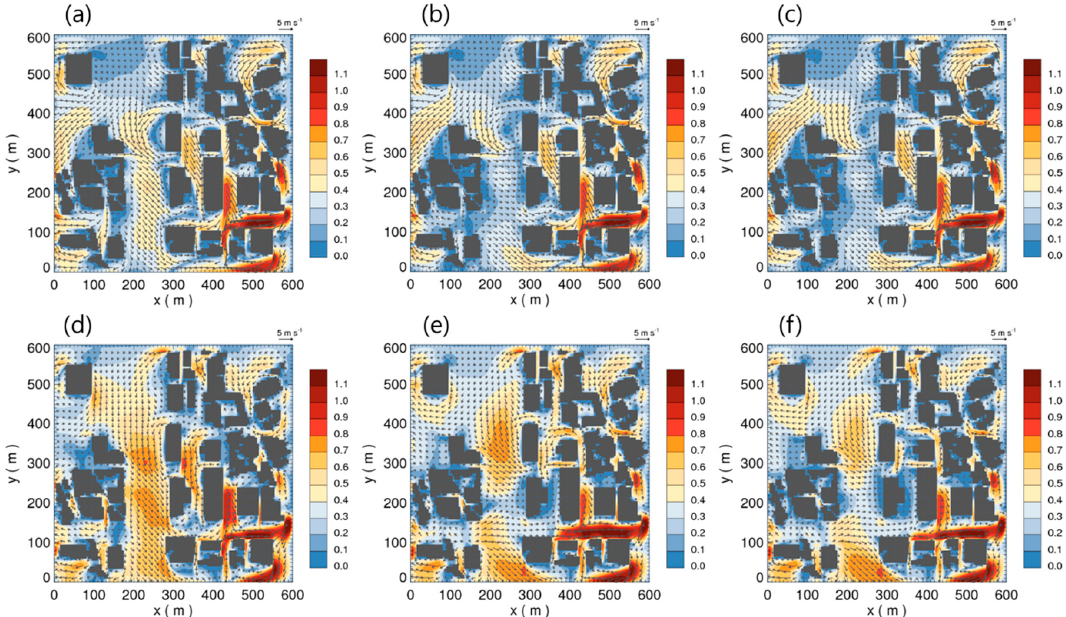
Figure 10. The spatial distributions of the simulated pedestrian-level wind fields with ( a, d ) no surface heating (neutral case), ( b, e ) homogeneous surface heating, and ( c, f ) heterogeneous surface heating. The upper and lower panels denote the results at 10 LST and 14 LST, respectively. The 1.5 m wind fields were plotted with arrows and the wind velocity ratio was denoted by the shaded contour.